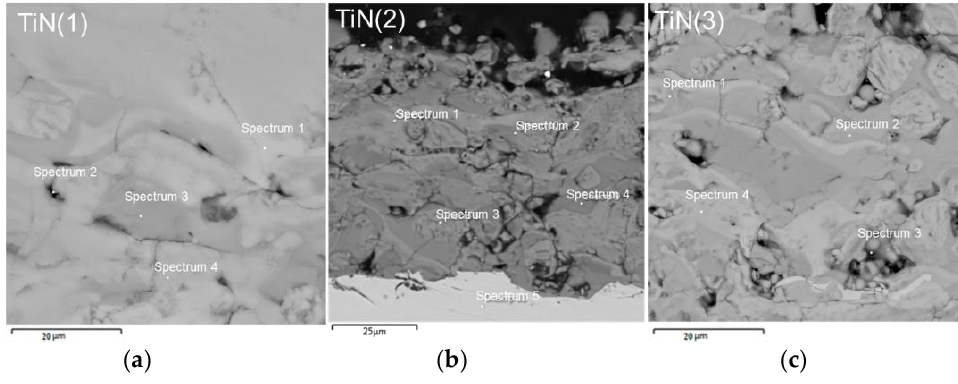
Figure 7. Cross-sectional structure of coatings: ( a ) TiN(1); ( b ) TiN(2); ( c ) TiN(3). Table 2. Results of EDS analysis of TiN coatings.